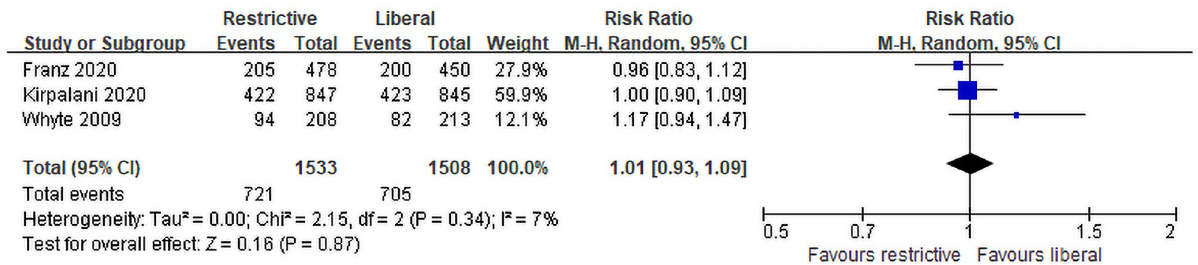
Fig 5. Forest plot comparing the composite death and neurodevelopmental impairment between restrictive and liberal RBC transfusion for VLBW infants. RBC: Red blood cell; VLBW: Very low birth weight.